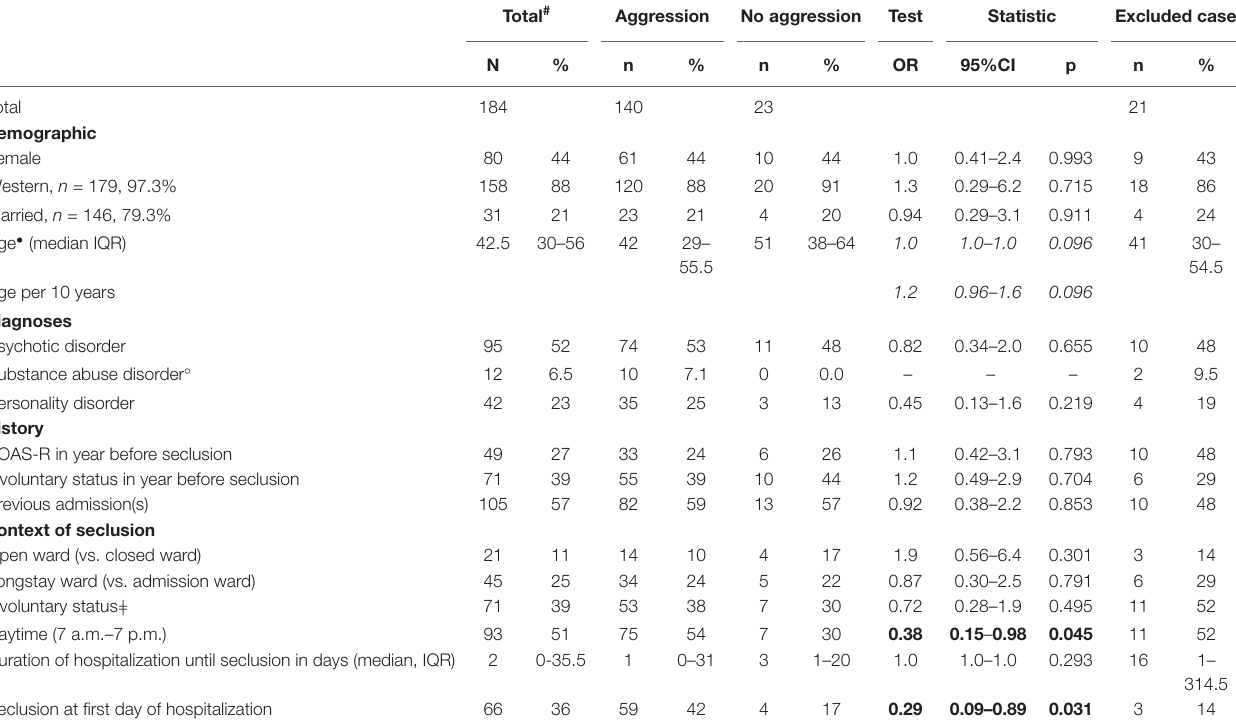
TABLE 1 | Univariable associations between patient, diagnostic, contextual, and aggression characteristics and no aggression preceding seclusion using logistic regression. Total # Aggression No aggression Test